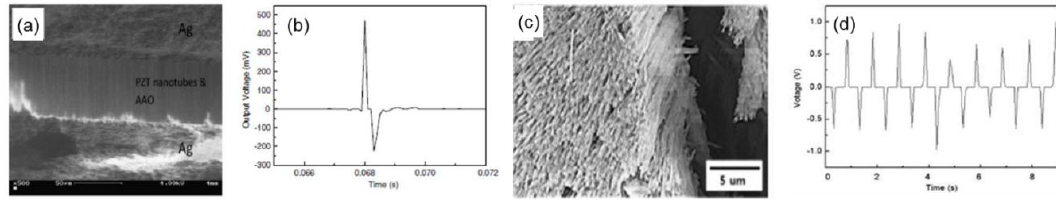
Figure 2. ( a ) Cross-sectional view of the device using PZT nanotubes [66]; ( b ) output voltage from the